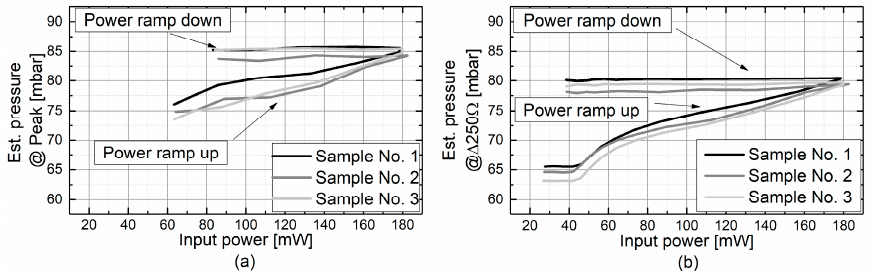
Figure 5. Estimated pressure at ( a ) peak resistance and ( b ) 250 Ohm